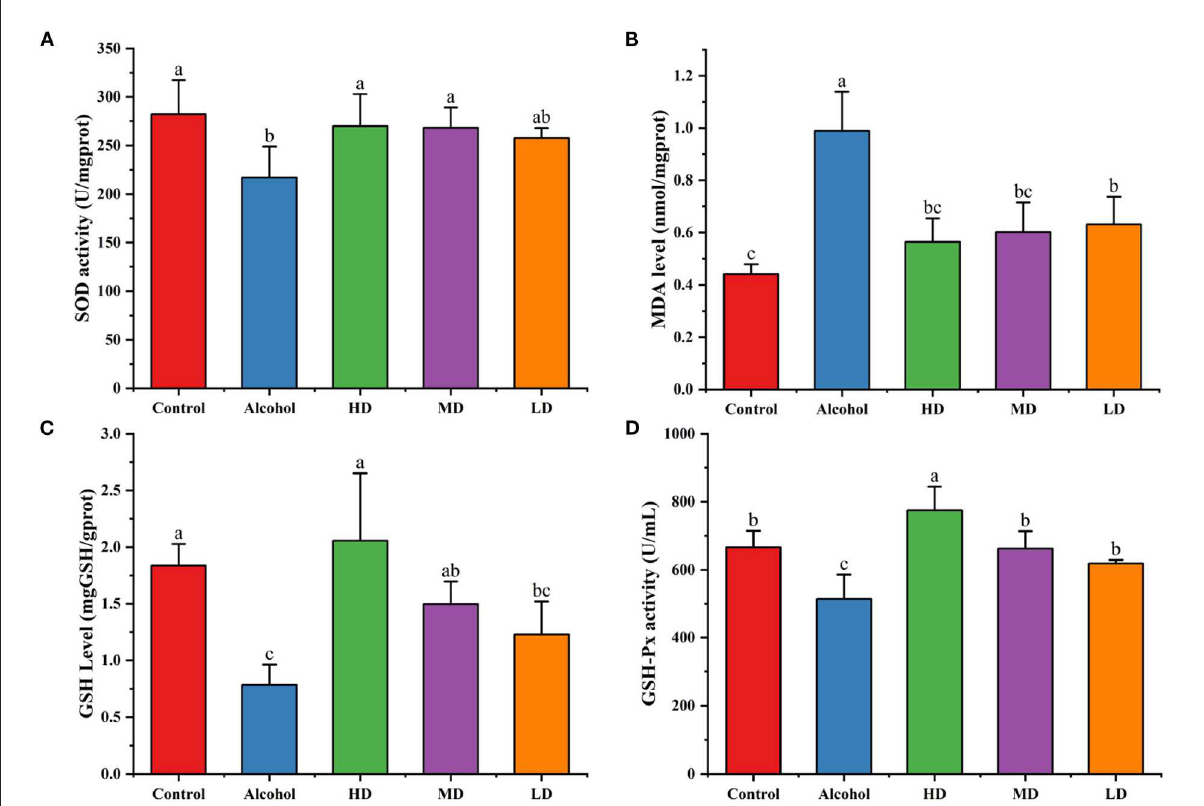
Figure 5D demonstrates the serum ethanol content of each group of mice 1h after gavage after lotus root extract intervention. Compared with the control group, the blood alcohol concentration of mice in the alcohol-treated group was significantly higher. Compared with the control group, the blood alcohol concentration of mice in the experimental group treated with lotus root extract was significantly lower ( p <